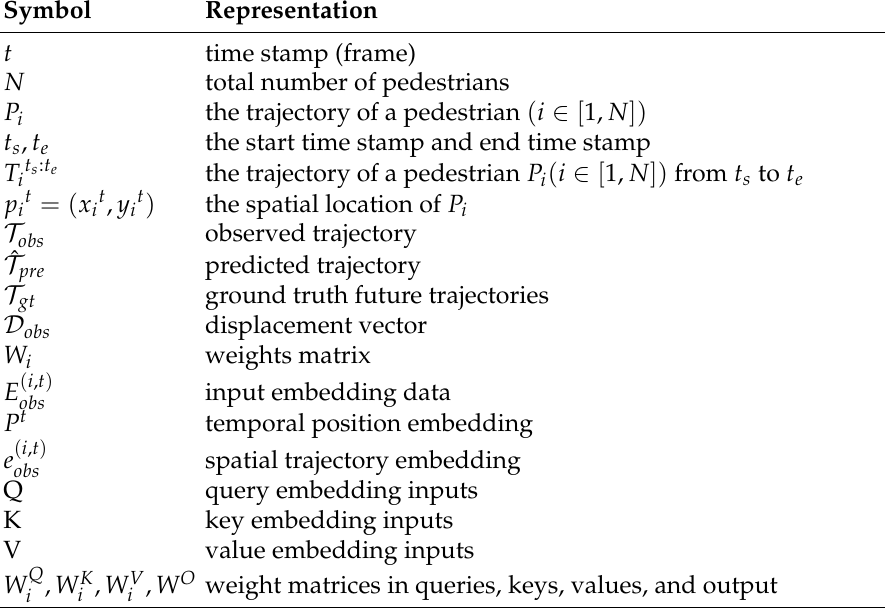
Table 1. Related mathematical symbols and their